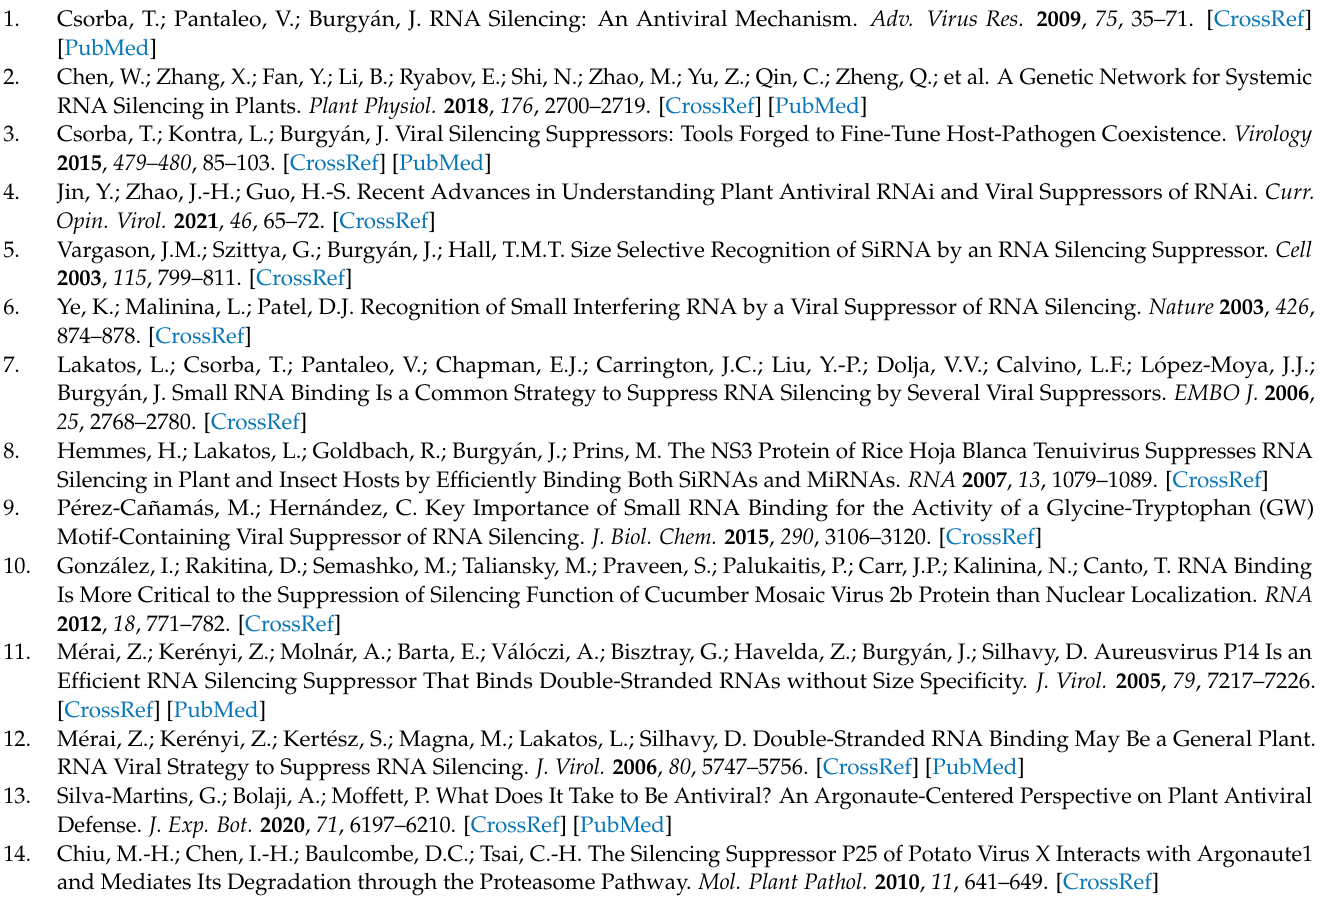
P0 gene variability, Figure S5: Western blot for detection of GFP, Figure S6: Western blot for detection of GFP, Figure S7: Western blot for detection of AGO1 and wt and mutant PeVYV-5 P0